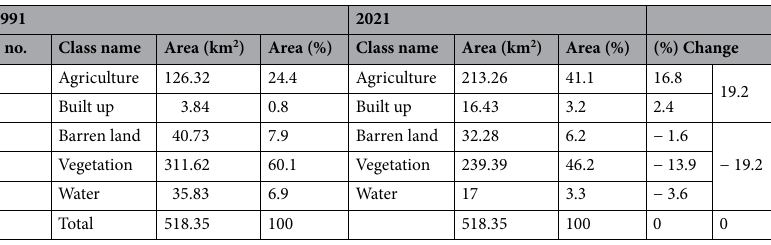
Table 1. Land use and land cover change analysis between 1991 and 2021.